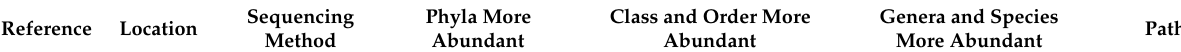
Table 1. Geographic localization, sequencing methods, bacteria community structure, and pathogens for each selected paper are